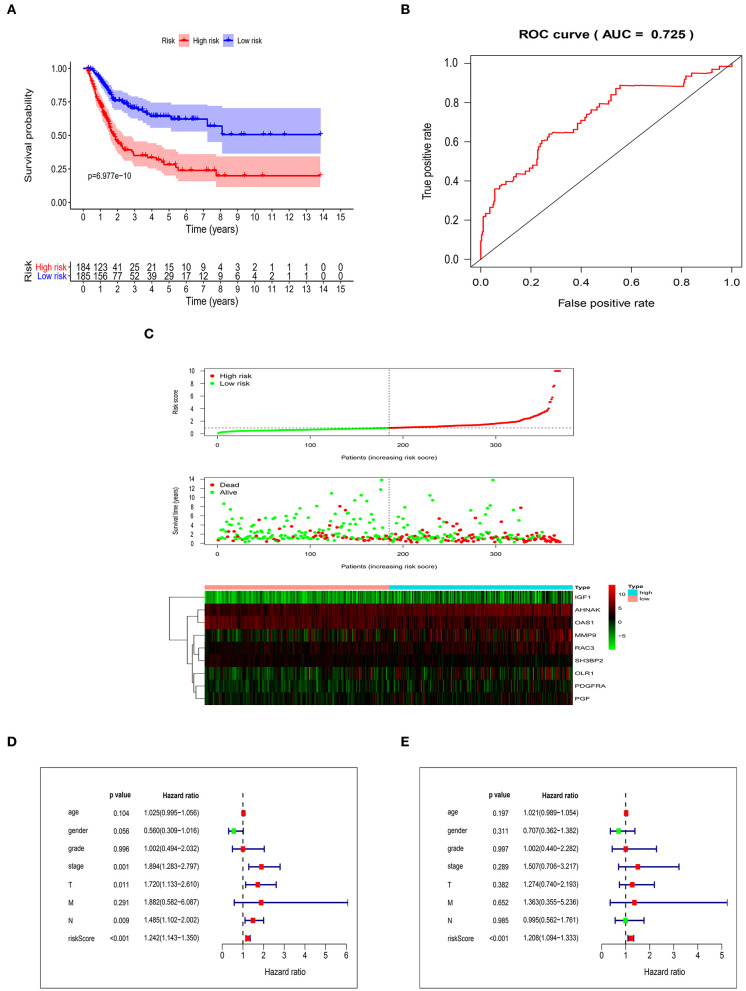
Validation of the risk score model. (A) Kaplan-Meier curve showing overall survival of urothelial carcinoma patients with high- and low-risk. (B) Analysis of time-dependent ROC curves. (C) Risk score distribution, survival status, and prognostic 9-core immune-related DEG patterns of urothelial carcinoma patients with high- and low-risk. Univariate (D) and multivariate (E) independent prognosis analysis of clinical parameters and risk score.